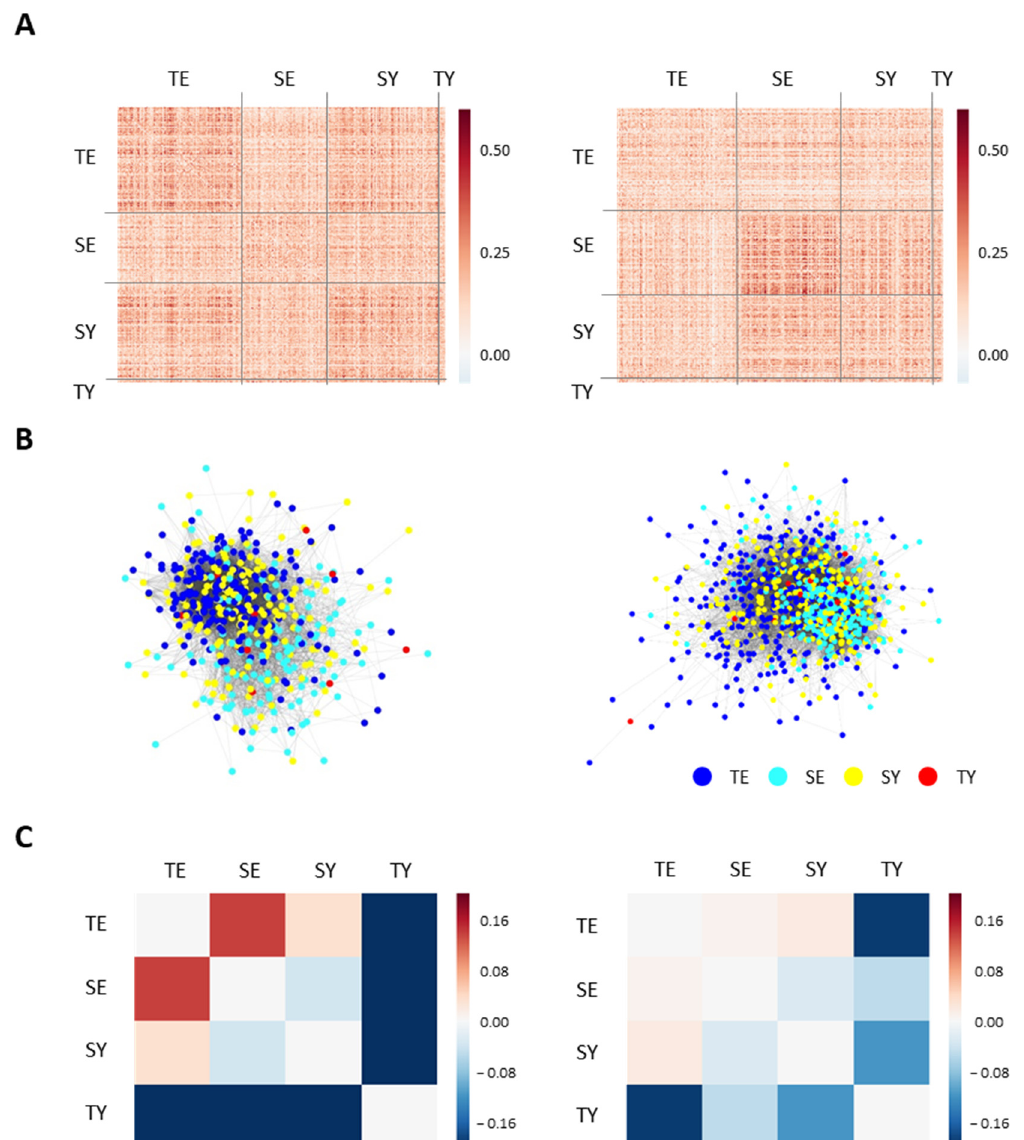
Figure 5. Patient network for men ( left column ) and women ( right column ): ( A ) distribution of adjusted MI value between patients; ( B ) the visualized patient networks. The nodes in the patient network represent patients, and the colors of each node indicate SC type. The edges of the network adjusted MI scores between patients; ( C ) the patient network separation between SC types. Positive separation values indicate that two SC types are well-distinguished at the network level, while negative values imply overlapping between two SC types.